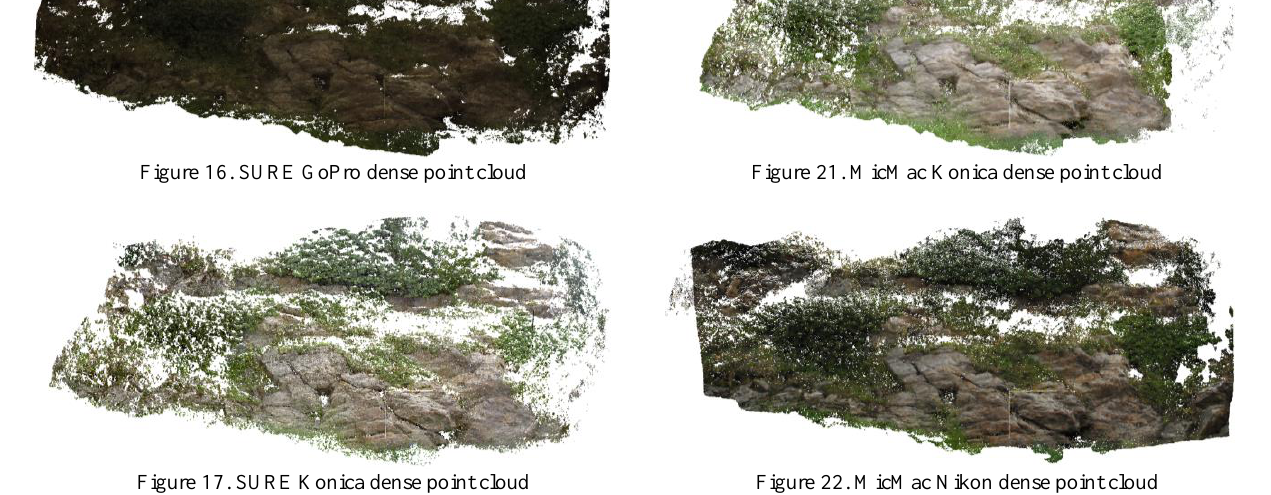
Figure 22. MicMac Nikon dense point